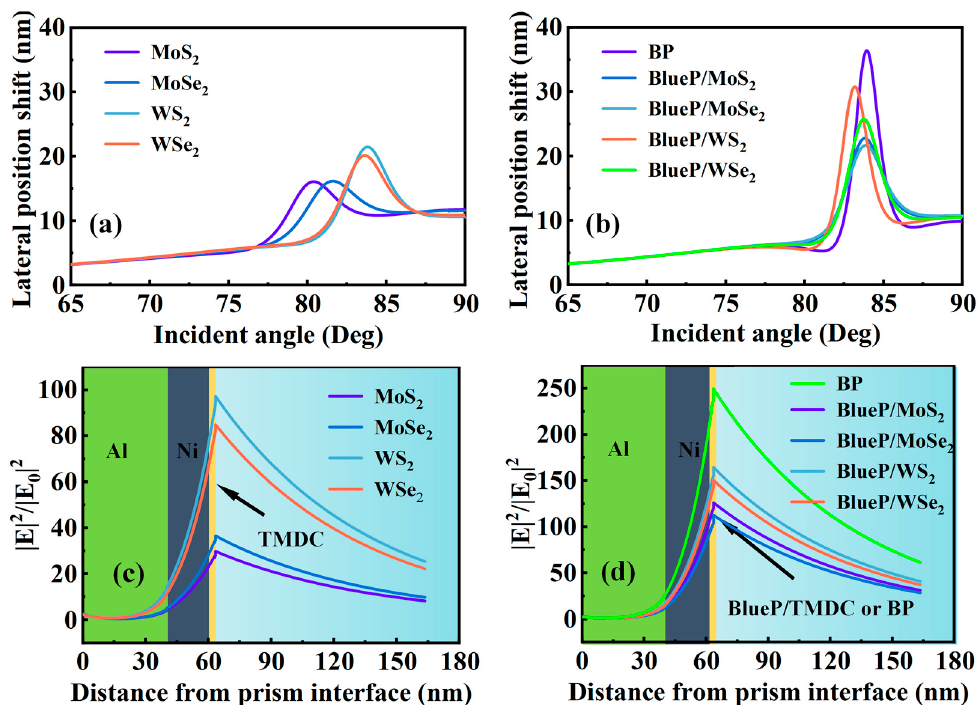
Figure 5. The lateral position shift of the proposed SPR sensor with ( a ) TMDC, and ( b ) BP and BlueP/TMDC. The electric field distributions of the proposed SPR sensor with ( c ) TMDC, and ( d ) BP and BlueP/TMDC.